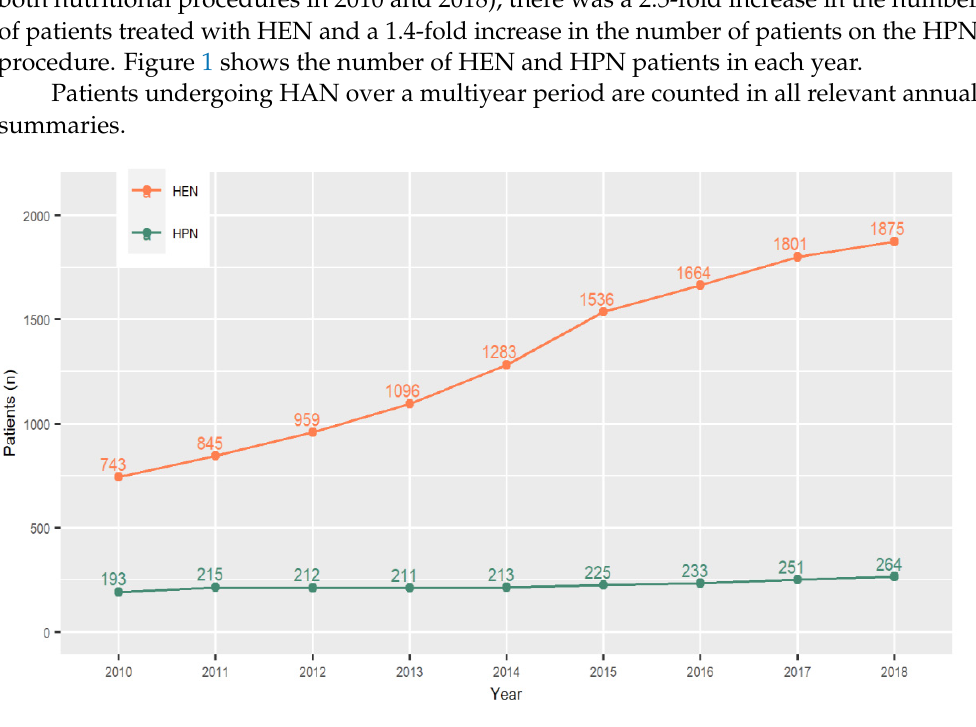
Figure 1. The number of patients undergoing home enteral nutrition (HEN) and home parenteral nutrition (HPN) between 2010 and 2018.